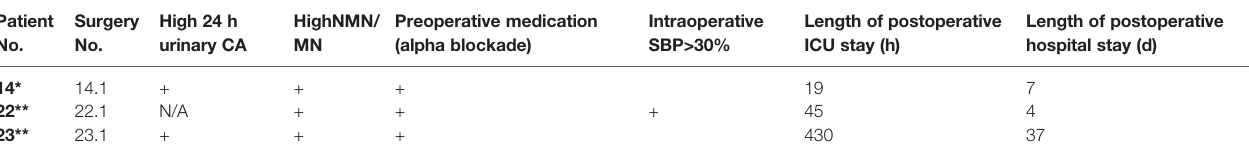
CA, catecholamine; NMN, nor-metanephrine; MN, metanephrine; SBP>30%, systolic blood pressure 30% above baseline. ICU, intensive care unit; +, yes; -, no; N/A, not available. *; presence of functional bilateral pheochromocytoma but the patient and her family preferred radical thyroidectomy for MTC before adrenalectomy for the symptoms and lymphatic metastasis of MTC. **; patients with previous history of bilateral pheochromocytoma resection surgeries admitted with unresectable pheochromocytoma (functional; recurrent; and malign) and progression of